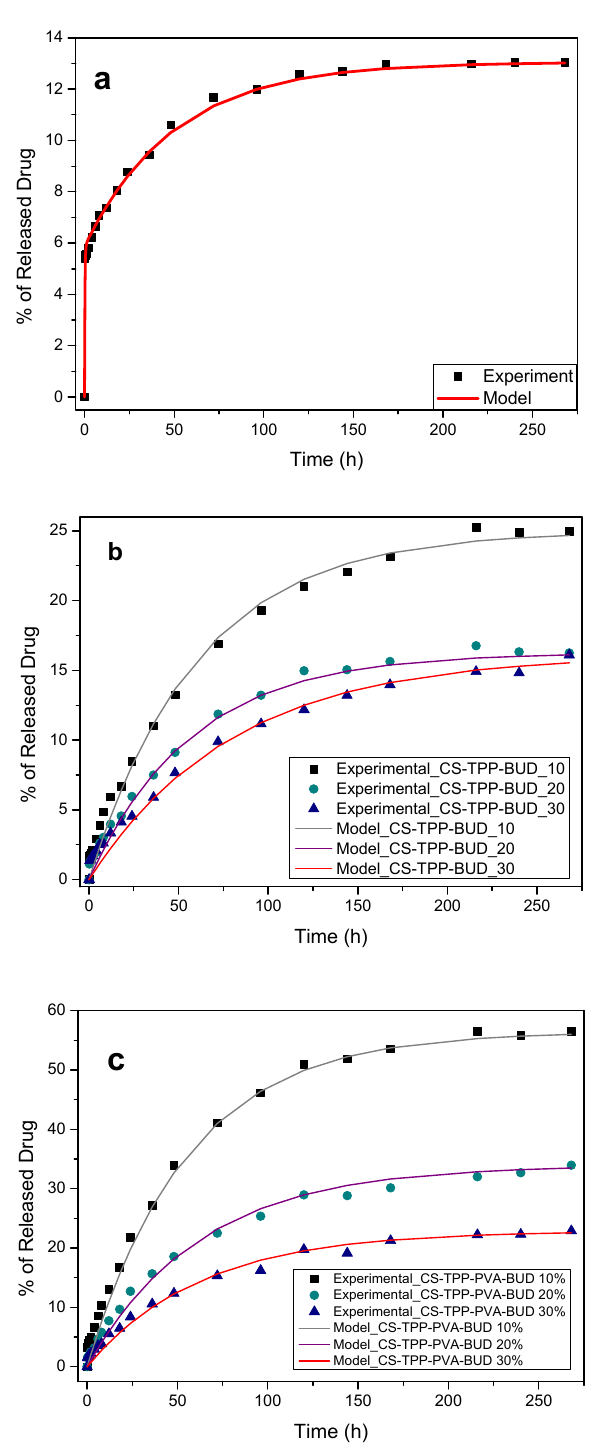
Figure 12. Comparison between experimental (symbols) and model (continuous lines) drug release data for ( a ) neat BUD ( b ) CS-TPP-BUD ( c ) CS-TPP-PVA-BUD.